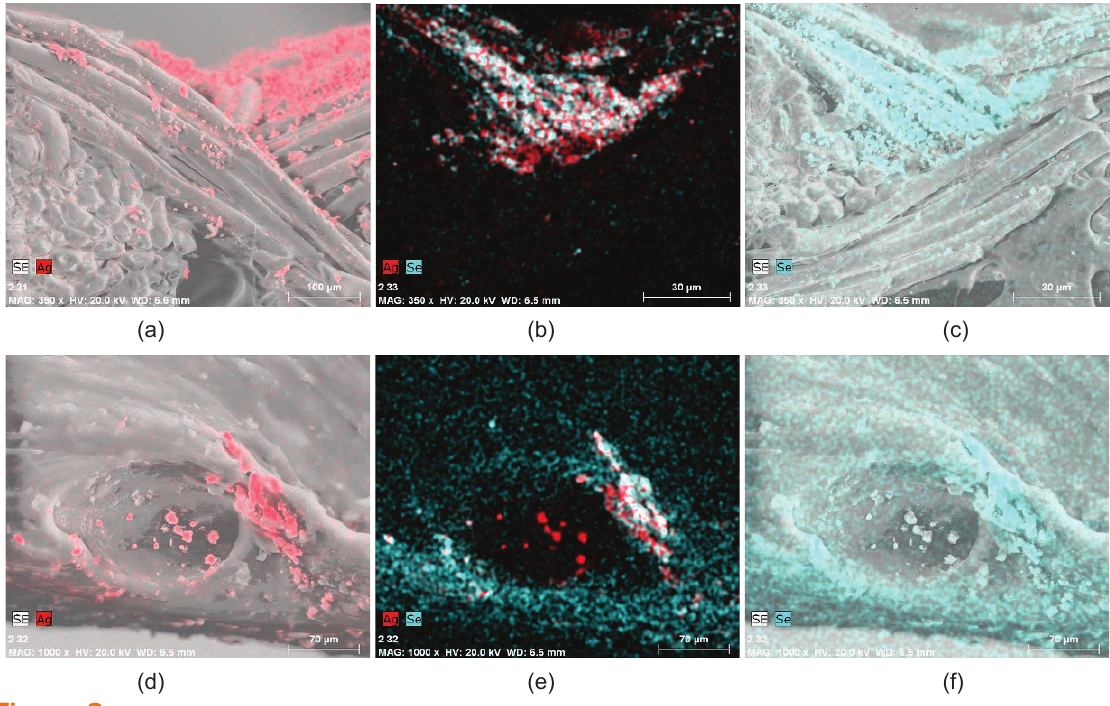
Figure 3. EDX mapping of the yarn surface (3a, 3b, 3c) and inside the coating layer (3d, 3e, 3f): 3a, 3d – silver; 3b, 3e – silver and selenium; 3c, 3f – selenium.